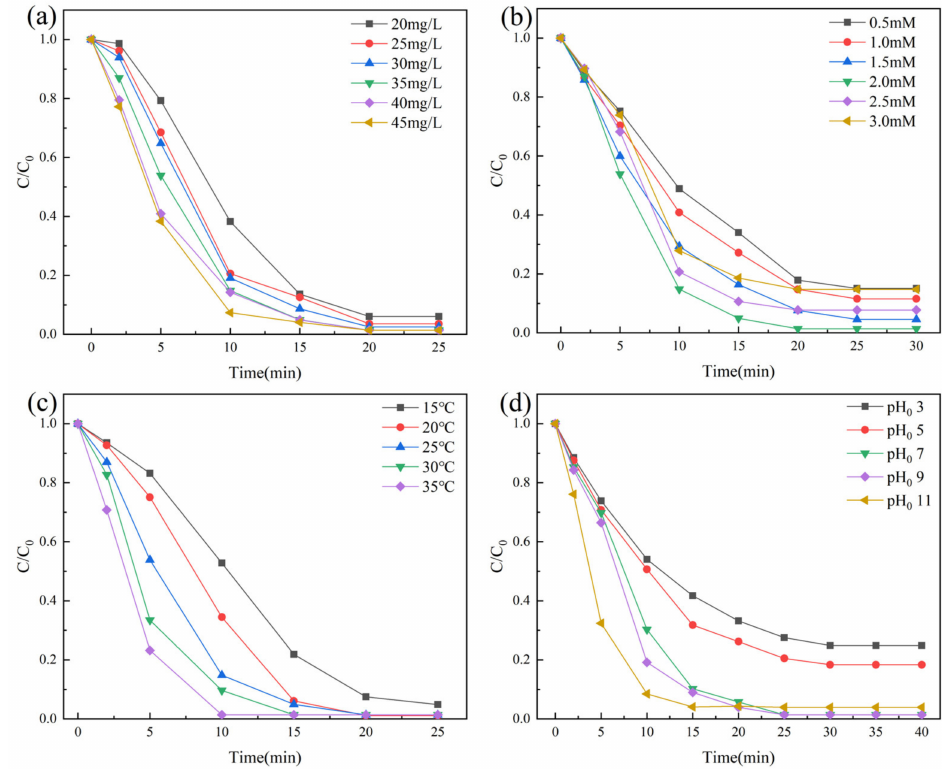
Figure 8. The effect of ( a ) catalyst dosage, ( b ) PMS concentration, ( c ) reaction temperature, and ( d ) initial pH values on the removal efficiency of CQP. (Experimental conditions: [[CQP] 0 = 10 mg/L, catalyst = 35 mg/L, PMS = 2.0 mM, initial pH = 6.5 ± 0.3, T = 25 ◦